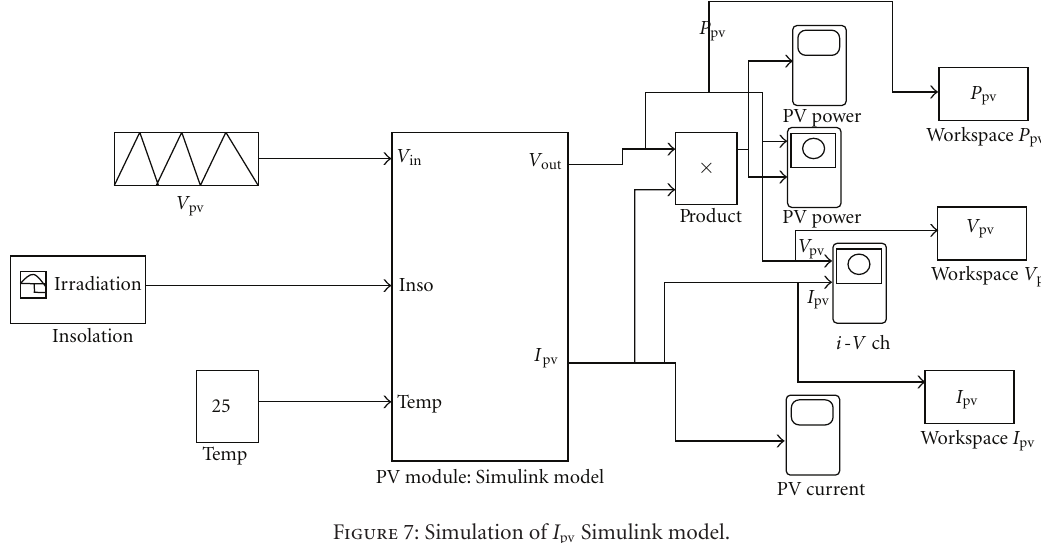
Figure 7: Simulation of I pv Simulink model.